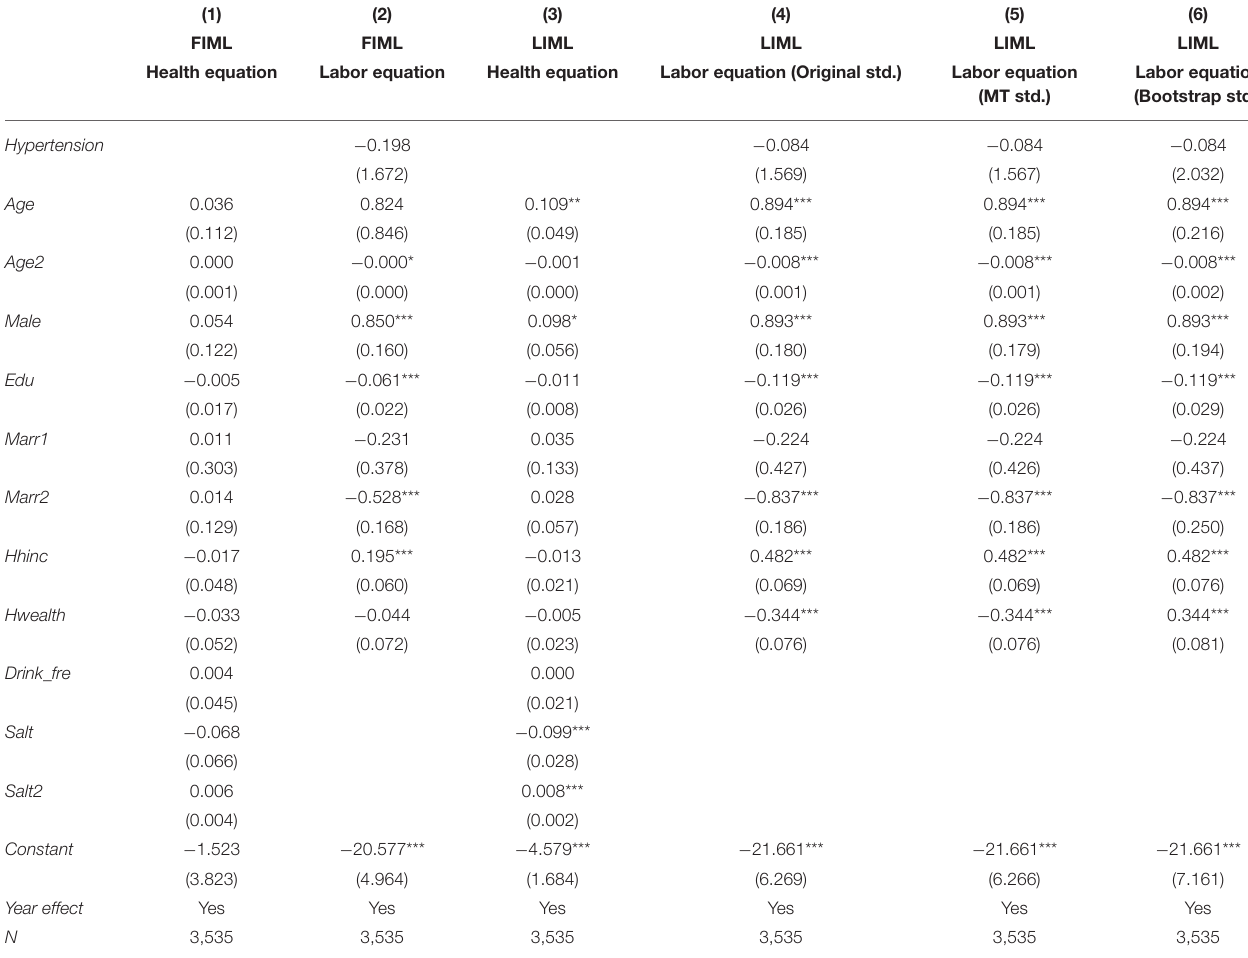
TABLE 4 | The effect of health on the elderly’s labor supply (using the objective indicator of health: Hypertension diagnosed or not).